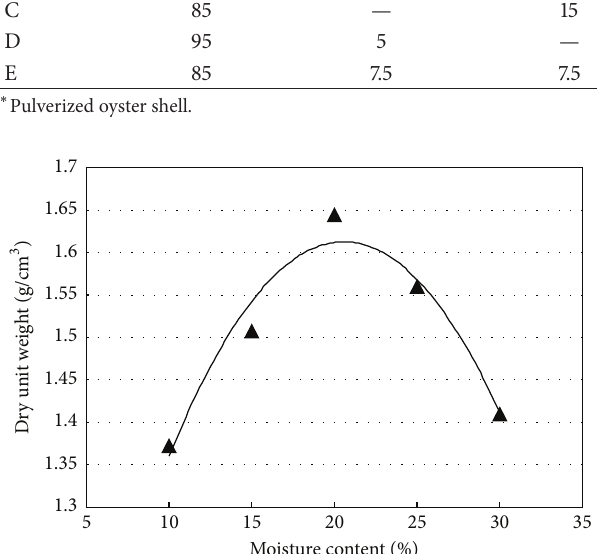
Figure 4: Compaction curve of soil group A.